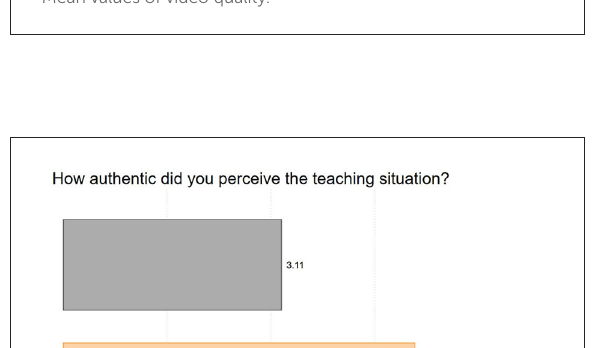
FIGURE2 Mean values of video quality.